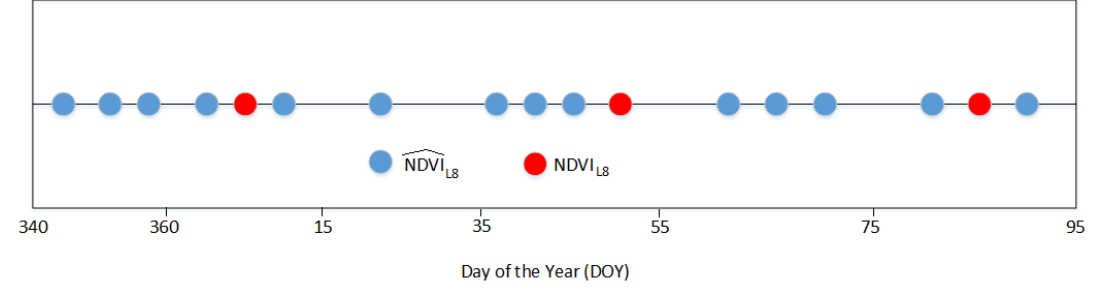
Figure 5. Composition of the NDVI (cid:48) multimodal time series during the growing season. Using this multimodal NDVI (cid:48) time series, the (cid:99) ET was estimated for each orchard and annual crop in the study